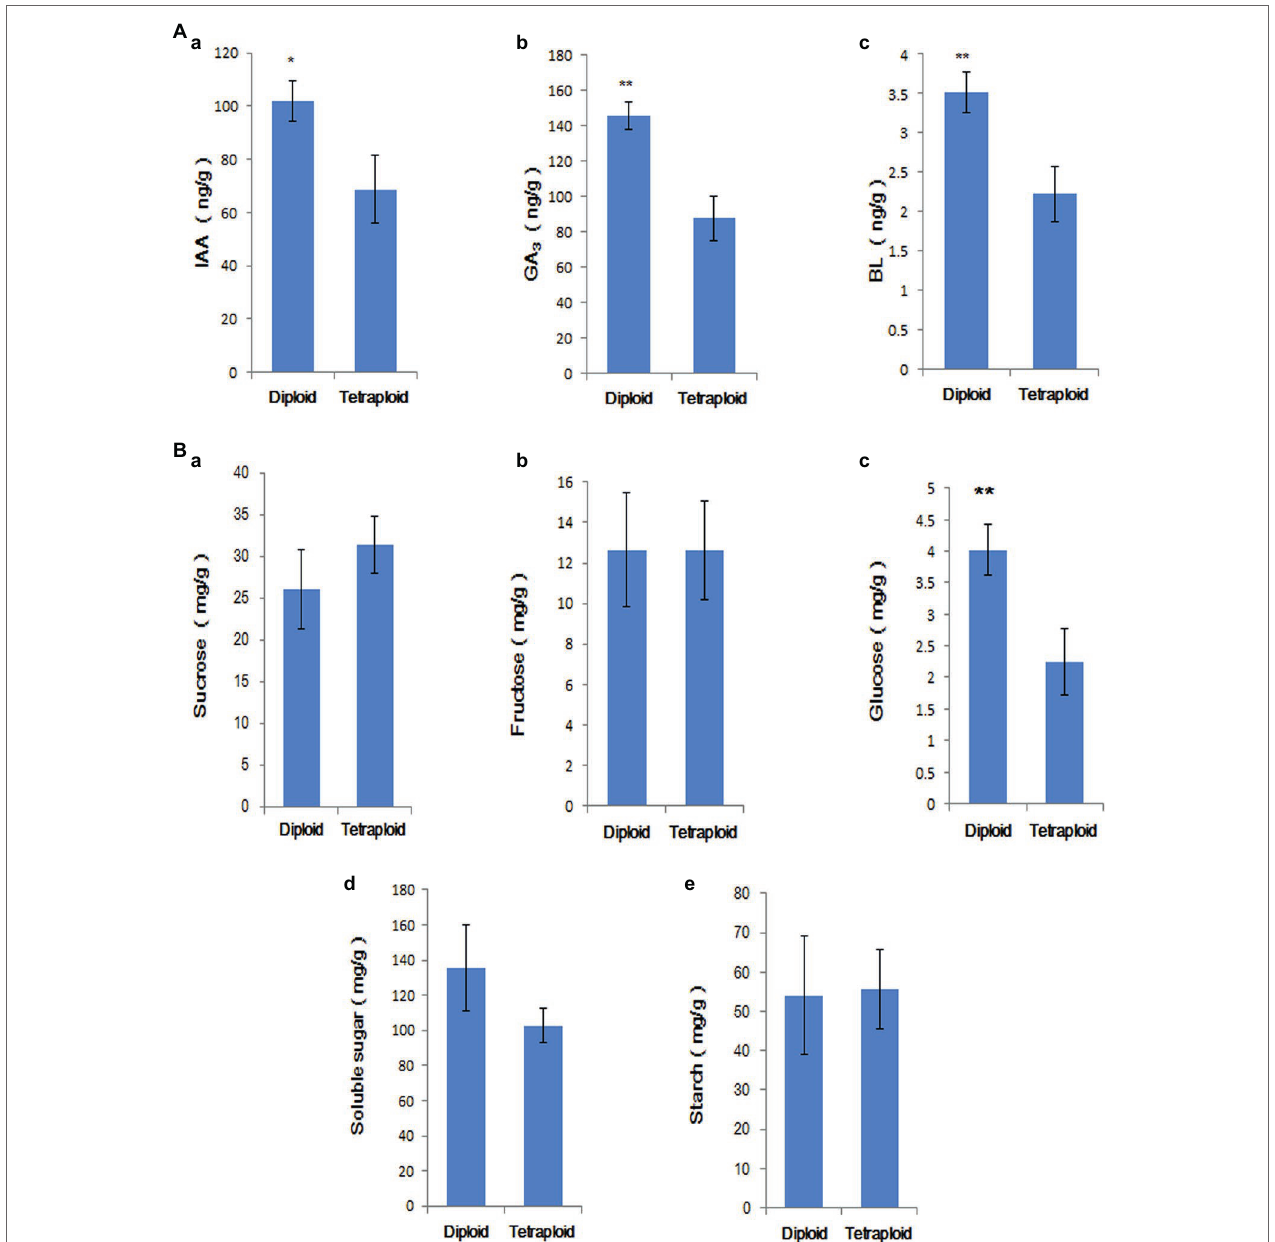
FIGURE 9 | (A) Comparison of IAA (a), GA 3 (b), and BR (c) contents in tetraploid and diploid stems and roots. ‘*’ indicates p < 0.05, ‘**’ indicates p < 0.01. (B) Comparison of sucrose (a), fructose (b), glucose (c), soluble sugar (d), and starch contents (e) in tetraploid and diploid stems and roots. ‘**’ indicates p <